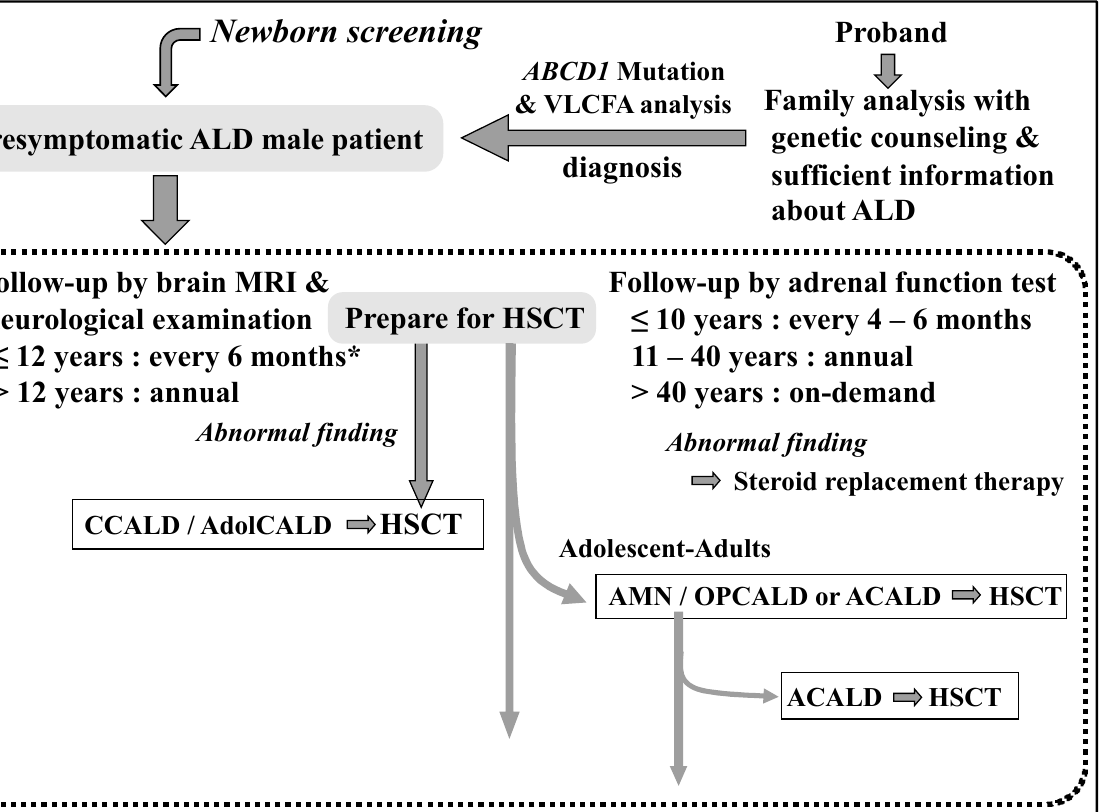
Figure 2. Follow-up flowchart for patients with pre-symptomatic adrenoleukodystrophy [8]. * start MRI follow-up at 12 to 18 months of age [13].